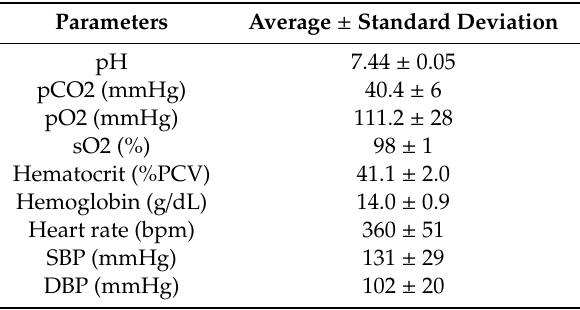
Table 1. Arterial blood gas data and vital signs during the PET measurement. DBP: diastolic blood pressure, SBP: systolic blood